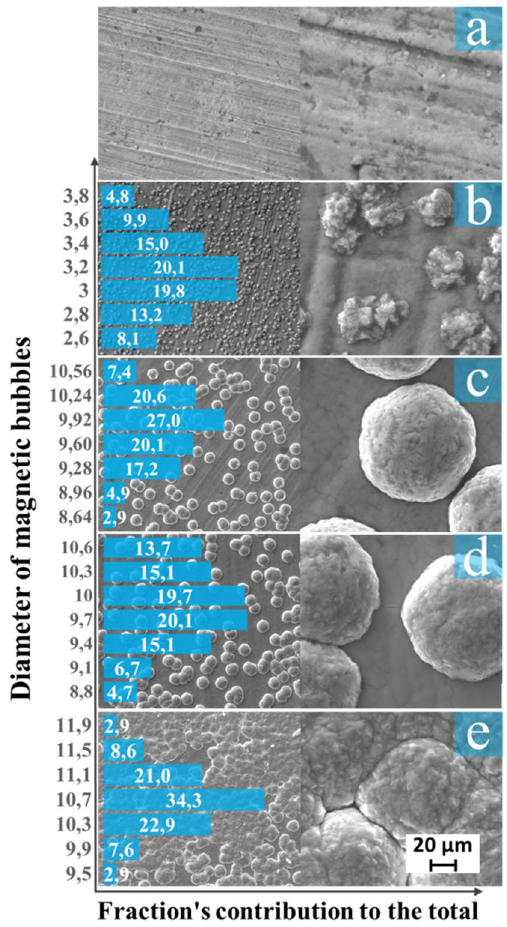
Figure 2. SEM images of the CoNiP films obtained with different deposition times and agglomeratesize distributions ( a ) CoNiP1; ( b ) CoNiP10; ( c ) CoNiP20; ( d ) CoNiP30; ( e ) CoNiP60.